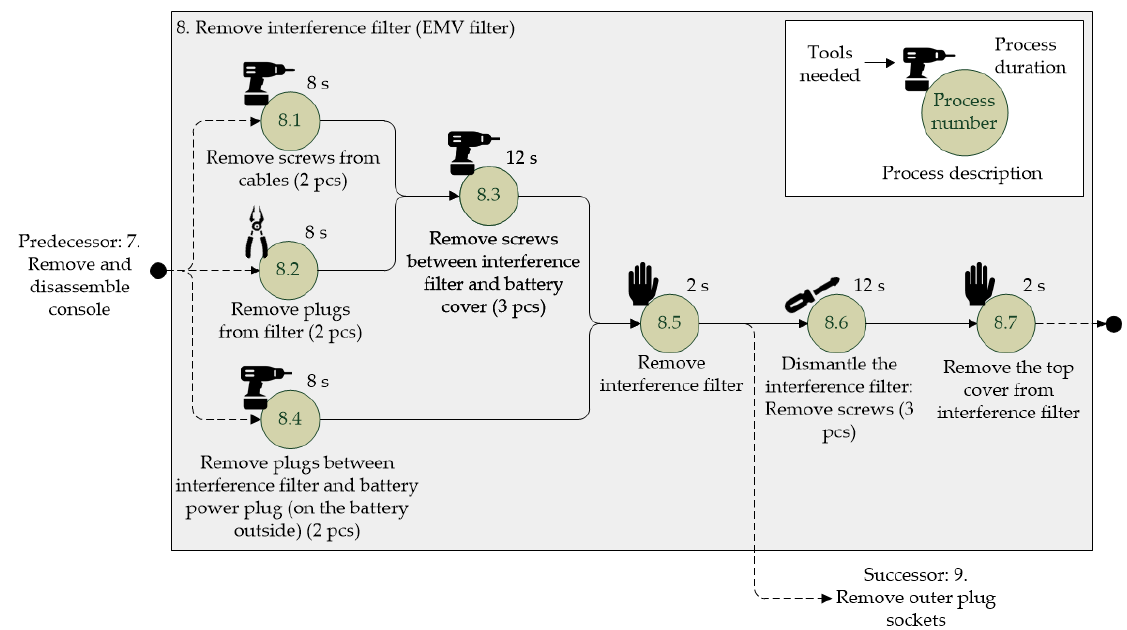
Figure 6. Detailed process description using the example “8. Remove interference